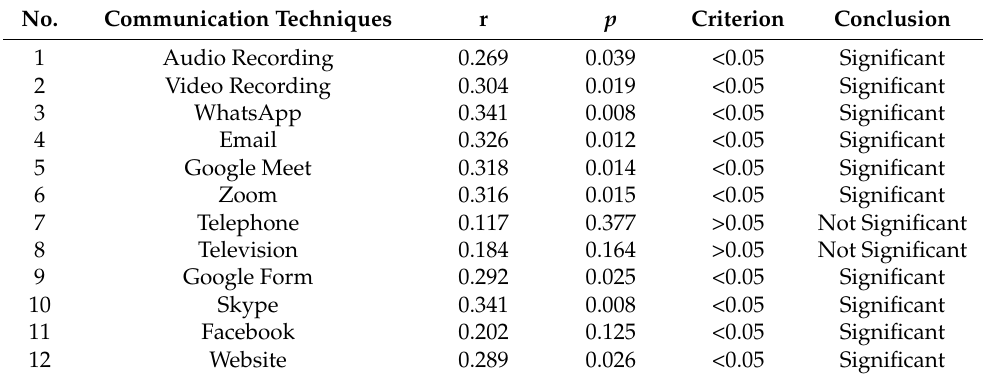
Table 2. Results of the zero-order correlation analysis of the effect of the use of ICT on instructional supervision and the quality of the teaching-learning